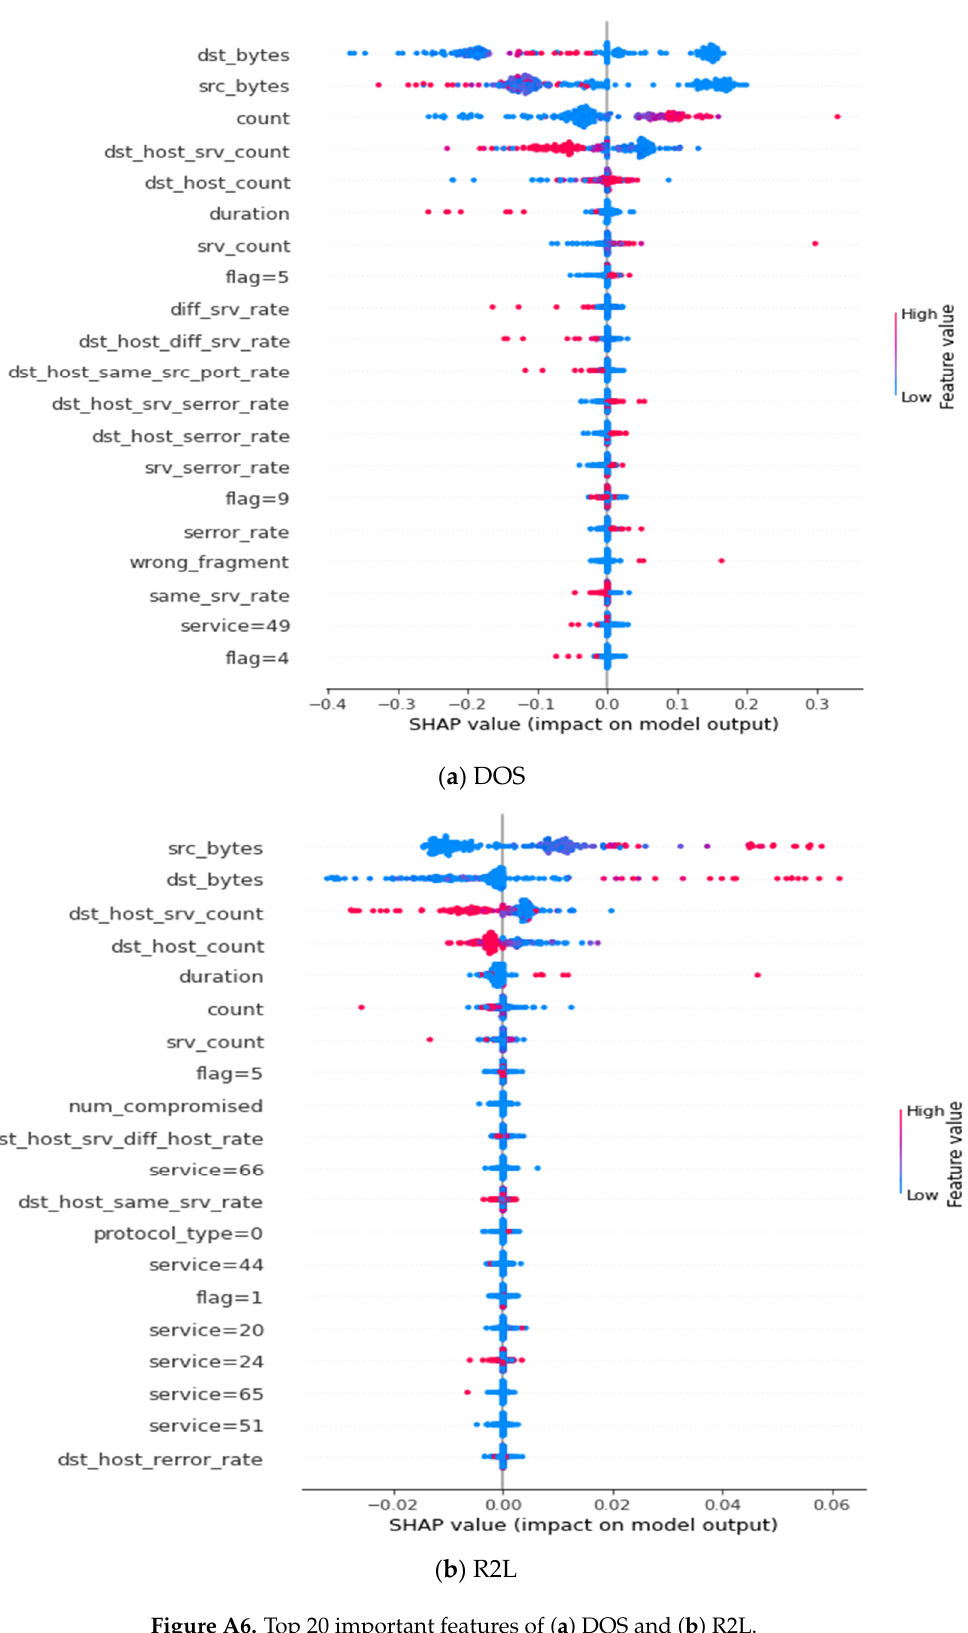
Figure A6. Top 20 important features of ( a ) DOS and ( b ) R2L.